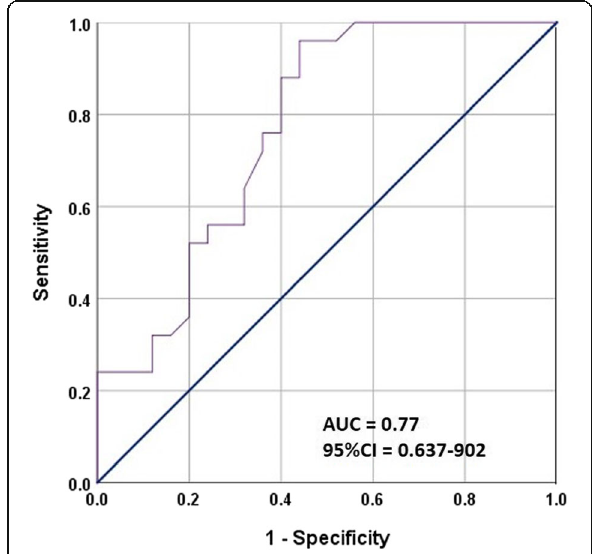
Fig. 3 Receiver operating characteristic curve for MMP-2 in the context of discrimination between epileptics refractory to treatment and controls. MMP-2, matrix